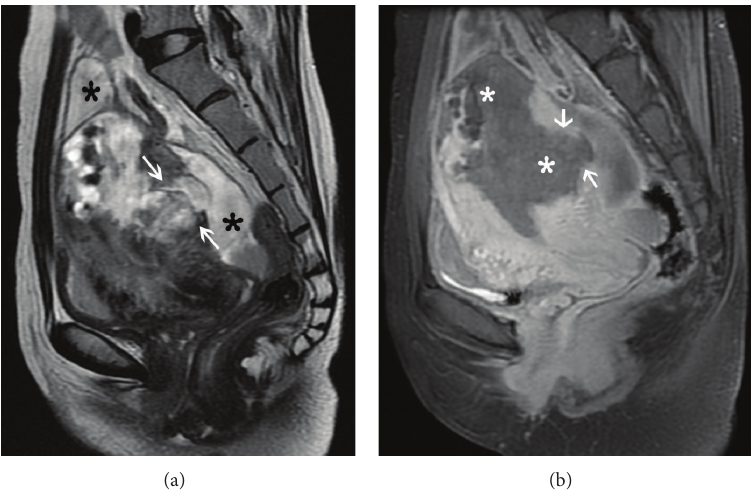
Figure 11: Bulky choriocarcinoma with myometrial rupture. Sagittal T2-weighted image (a) shows an ill-defined heterogeneous mass in the uterine fundus and posterior corpus with full thickness myometrial penetration (arrows) and associated fluid collection (black asterisk) around the uterus. Sagittal contrast-enhanced fat-suppressed T1-weighted MR image (b) demonstrates the mass to be completely necrotic with a large myometrial perforation showing focal continuity (arrows) with the collection in the pouch of Douglas.